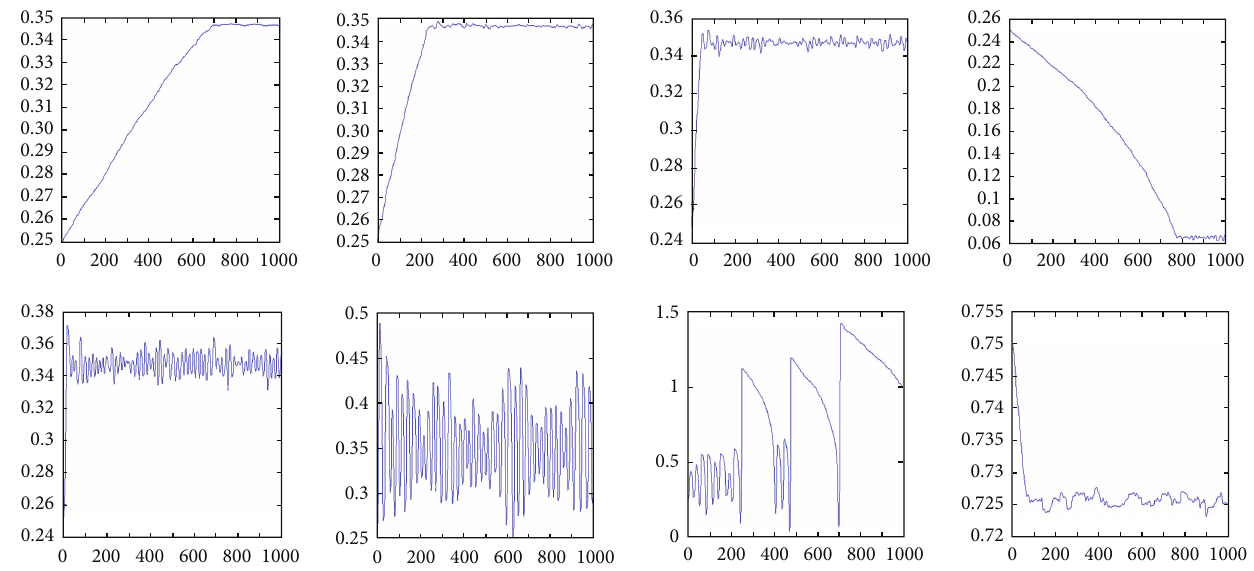
Figure 2: The optimization results for different 𝛾 𝑓 and 𝛼